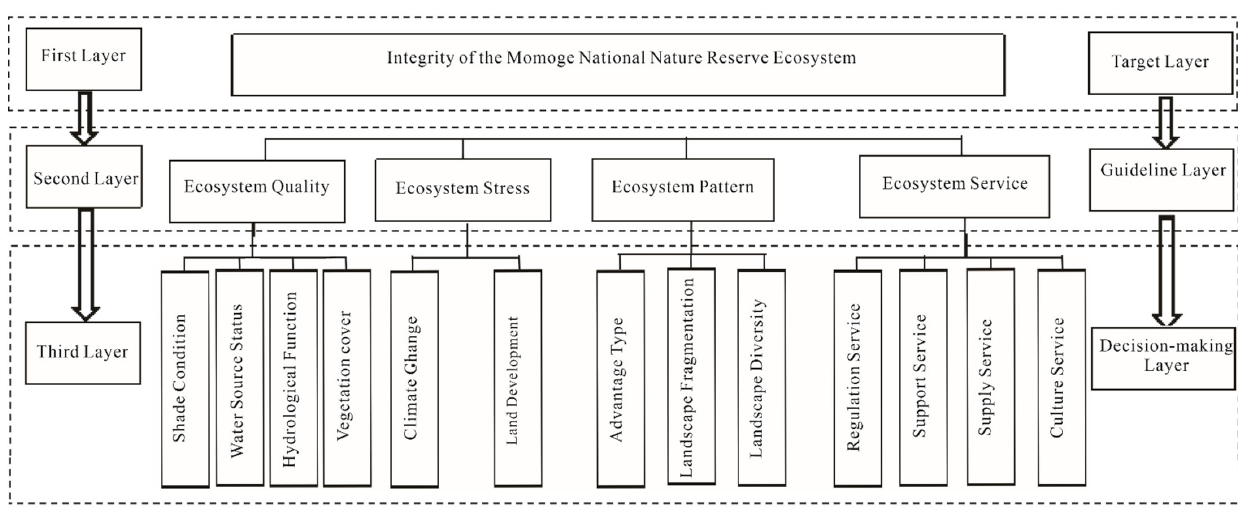
Figure 3. “Quality ‐ Pressure ‐ Pattern ‐ Service” ecosystem integrity remote assessment